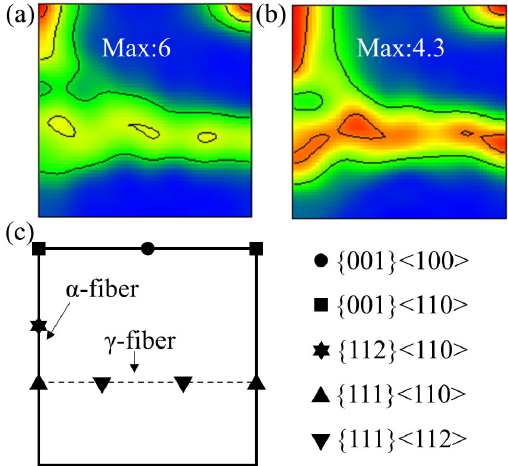
Figure 7. The φ 2 = 45° sections in orientation distribution function (ODF) maps of the steel layers: ( a ) initial sample, ( b ) aged sample, and ( c ) the typical positions of the main textures.